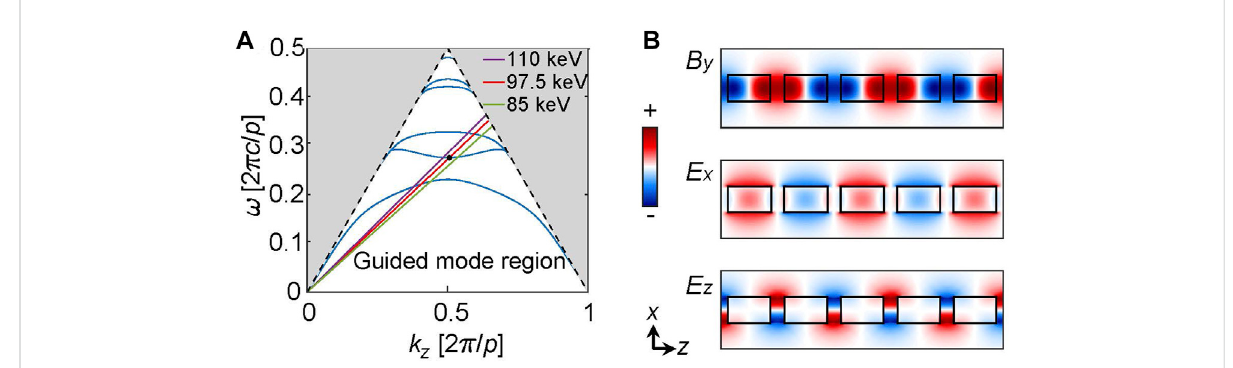
FIGURE 2 (A) Dispersion diagram of the SWG calculated by CST. The gray area above the black dashed lines are the radiation continuum. The 85, 97.5, 110 keVelectronlinesare indicatedbythegreen, red,andpurple solidlines, respectively. (B) The B y , E x and E z fi eldpro fi lesoftheBragg resonance at the black dot in (A) . The silicon bars are depicted by the rectangles with solid black